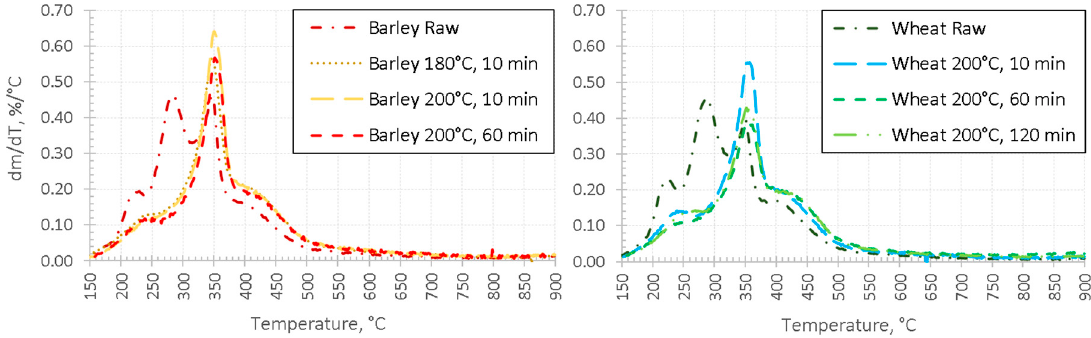
Figure 10. Results of TGA analysis of spent grains from Barley ( left ) and Wheat ( right ) and their respective hydrochars, produced in different HTC conditions (pyrolysis conditions–N 2 ).